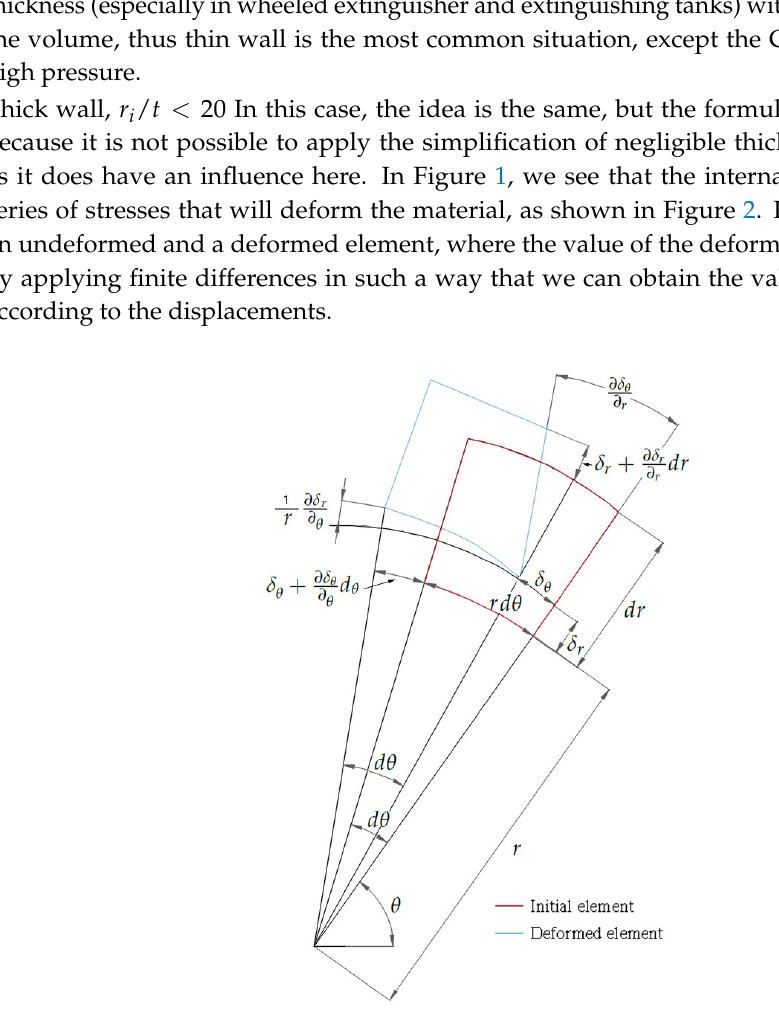
Figure 2. Deformation scheme: thick-walled